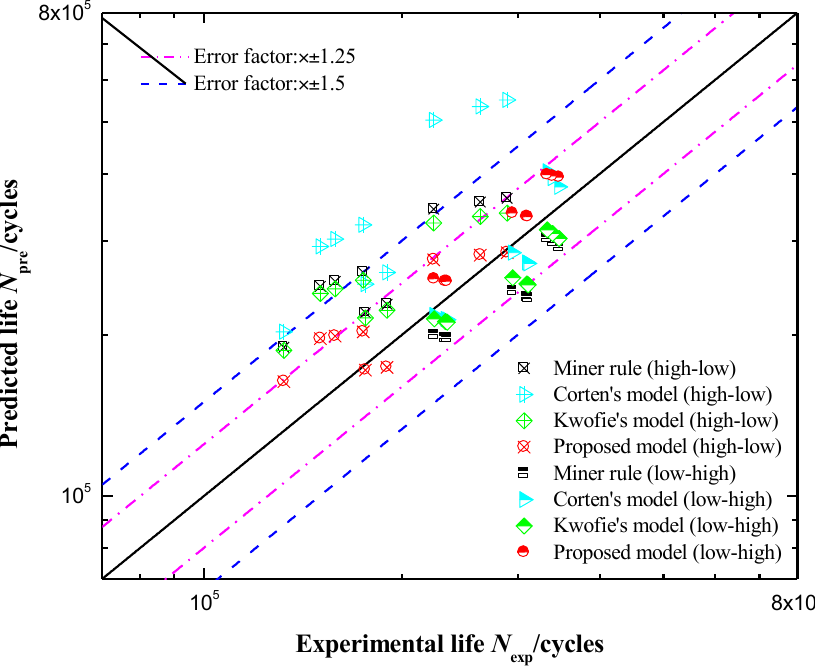
Figure 4. Comparison between the experimental lives and the predicted lives by Miner rule, Corten’s model, Kwofie’s model, and the proposed model for Al-2024-T42 aluminum alloy.